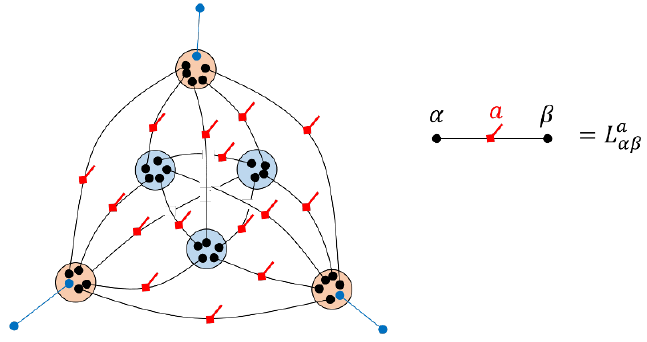
Figure 3 . Illustration of the random tensor network on a complete graph with link states. Each bulk link is a three-leg tensor L a , and each vertex is a random tensor. The blue links are maximally (cid:11)(cid:12) entangled EPR pairs. The network de(cid:12)nes a linear map between bulk link states (red lines) and boundary states (blue